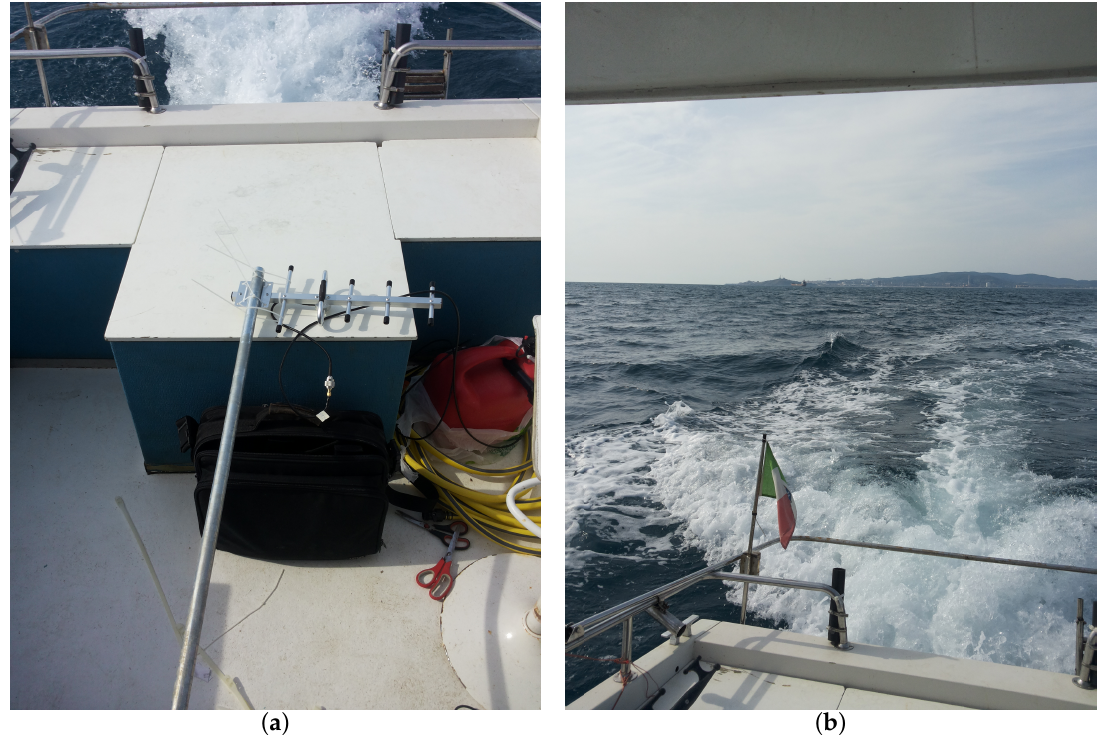
Figure 5. Offshore setup for the measurements campaign: ( a ) offshore end node antenna and its pole; ( b ) view approaching the tests